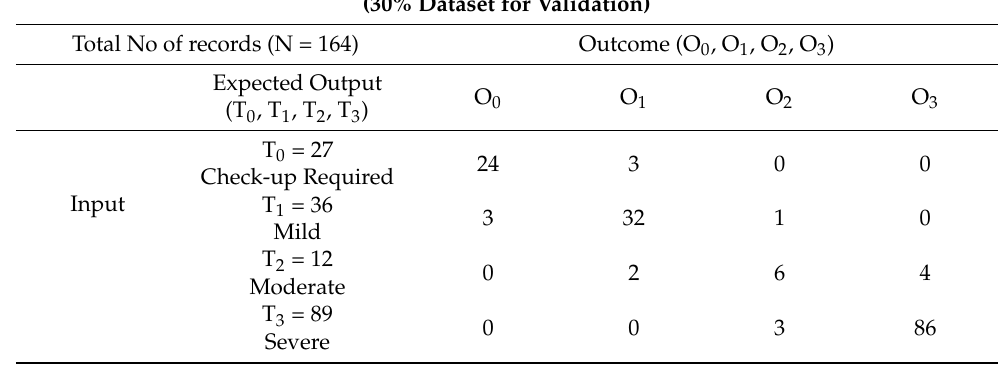
Table 3. Validation of the proposed Vehicle-based COVID-19 Detection System (VCDS) during the prediction of COVID-19.